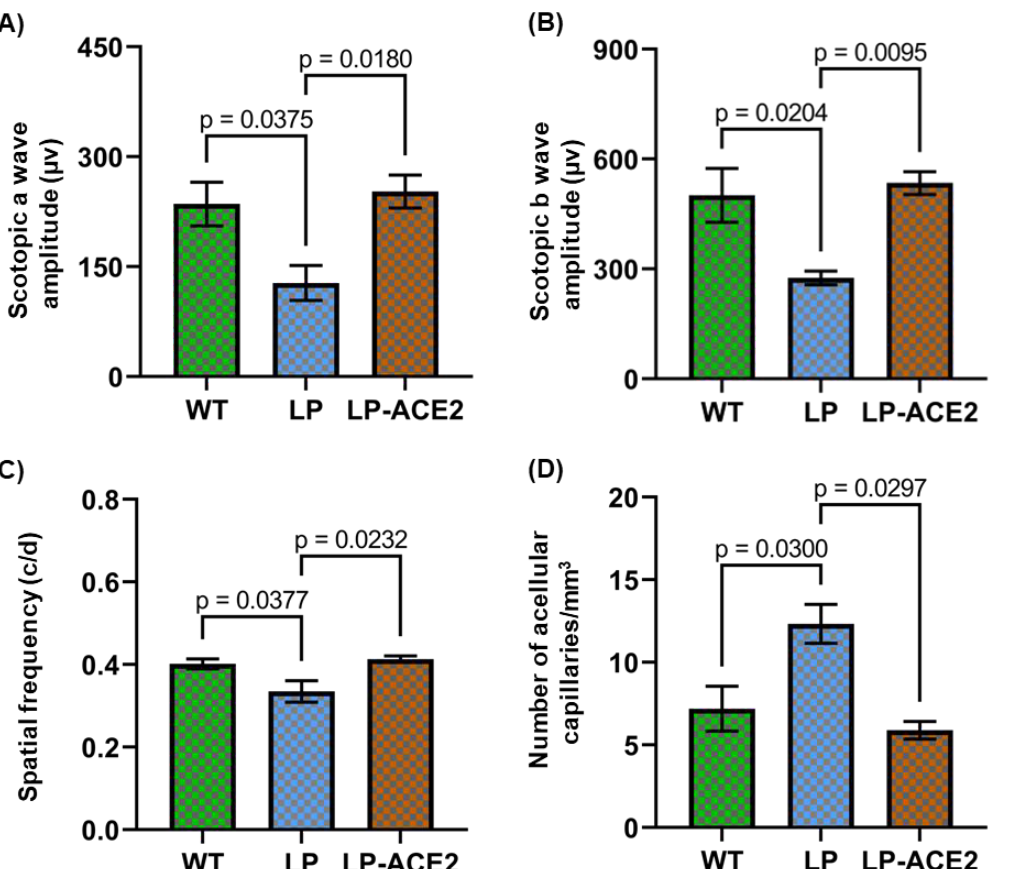
Figure 5. LP-ACE2 treatment corrects visual dysfunction and decreases acellular. capillary in Akita mice. After 3 months of LP-ACE2 treatment, the visual function in Akita mice was assessed by ERG and OKN. The amplitude of scotopic a-wave ( A ) and scotopic b-waves ( B ). Assessment of visual acuity using OKN demonstrates an increase in spatial frequency ( C ). In all three cohorts, the enumeration of acellular capillaries s summarized and presented as mean number of acellular capillaries/mm 3 ± S.E.M ( D ). Data are analyzed by one-way ANOVA adjusted to account for multiple comparisons using Tukey’s test ( n = 6).